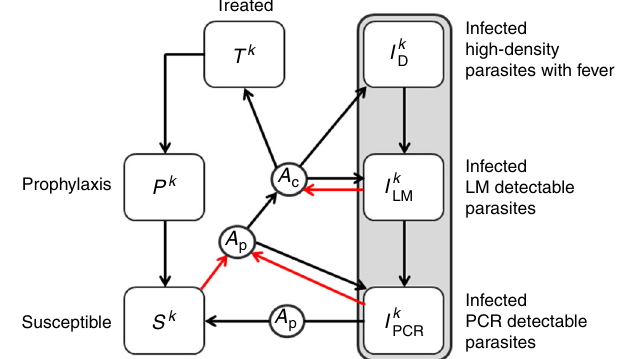
Fig. 6 Compartmental representation of P. vivax transmission model in humans. Infected individuals can be in one of three compartments depending on whether blood-stage parasitaemia is detectable by PCR ( I PCR ), light microscopy ( I LM ) or has high density with accompanying fever ( I D ). A proportion of individuals that progress to a symptomatic episode of P. vivax will undergo treatment with a blood-stage drug ( T ) leading to clearance of blood-stage parasitaemia and a period of prophylactic protection ( P ) before returning to the susceptible state ( S ). The superscript k denotes the number of batches of relapse causing hypnozoites in the liver. Red arrows denote new blood-stage infections arising from either new mosquito bites or relapses. Each square denotes a compartment and the circles denote the dependence of transition rates between compartments on levels of anti-parasite immunity ( A p ) and levels of clinical immunity ( A c